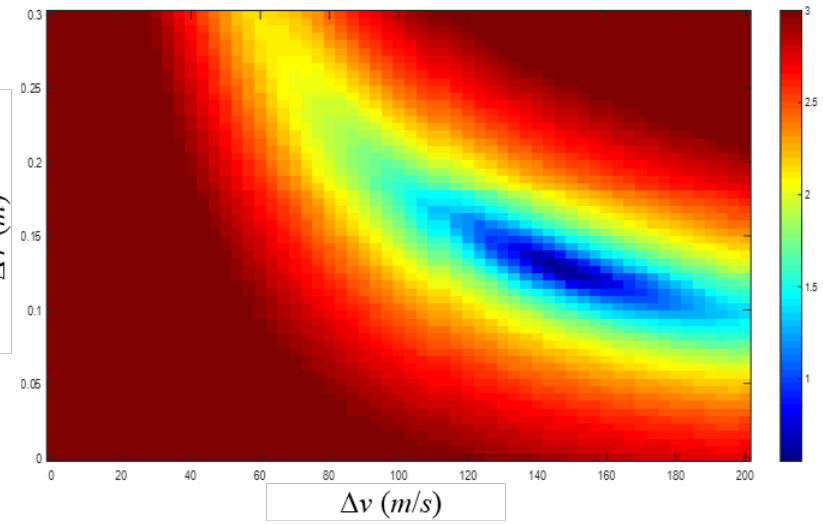
Figure 4. Two-dimensional correlation image of objective function in high-frequency constrained inversion.